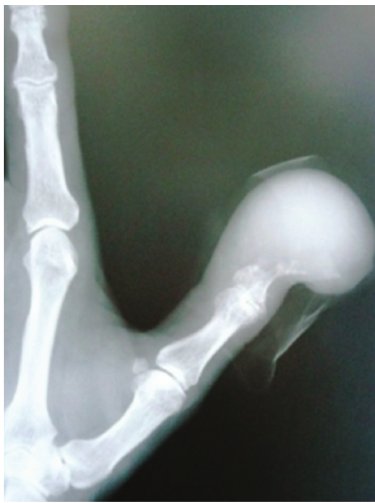
Figure 2: Radiological view of thumb: soft-tissue swelling and lysis of the distal phalanx of thumb.